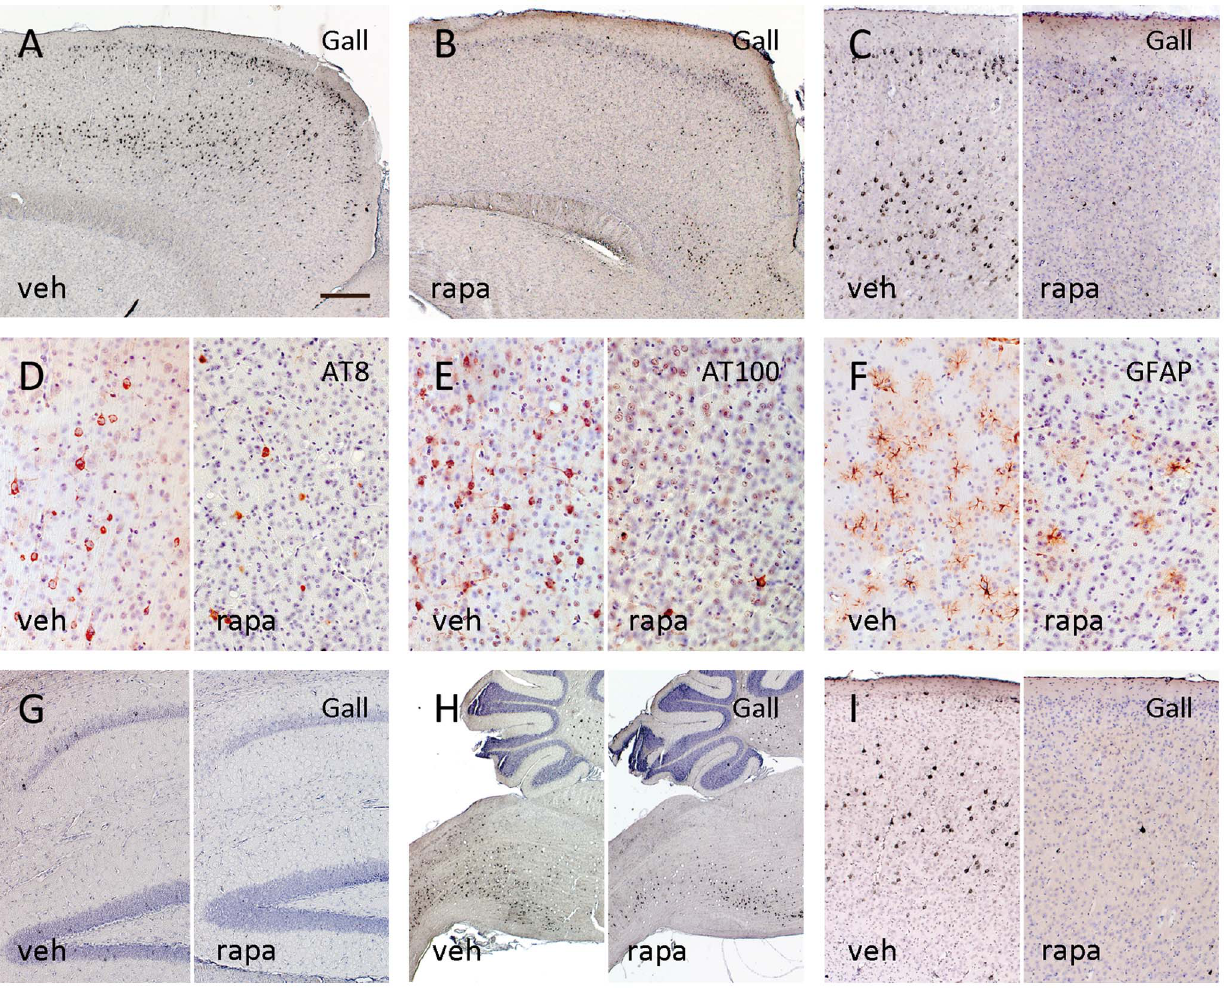
Figure 1. The extensive cortical tau tangle pathology present in 5.5 months old vehicle (veh) treated P301S mice (A) was widely attenuated in long-term rapamycin (rapa) treated mice (B). The lowering in tangle formation was most pronounced in the motor cortex (C: left vehicle treated/right rapamycin) and associated with reduced pathological tau hyperphosphorylation at the AT8 and AT100 epitopes (D, E). In parallel, cortical astrogliosis was diminished following rapamycin treatment (F). While there was a trend towards a reduction of the sparse tangles in the hippocampus, the advanced tau pathology in the brain stem however was not significantly ameliorated by rapamycin (G, H). Short-term treatment at 3 months of age for 6 weeks again resulted in a marked reduction of cortical tangles (I) (A–H: 5MT group; I: 6WT. A–C, G–I: Gallyas silver stain; D: AT8 IHC; E: AT100 IHC; F: GFAP IHC. Bar in A equals 300 m m in A and B, 150 m m in C, G and I, 75 m m in D–F, 600 m m in H).